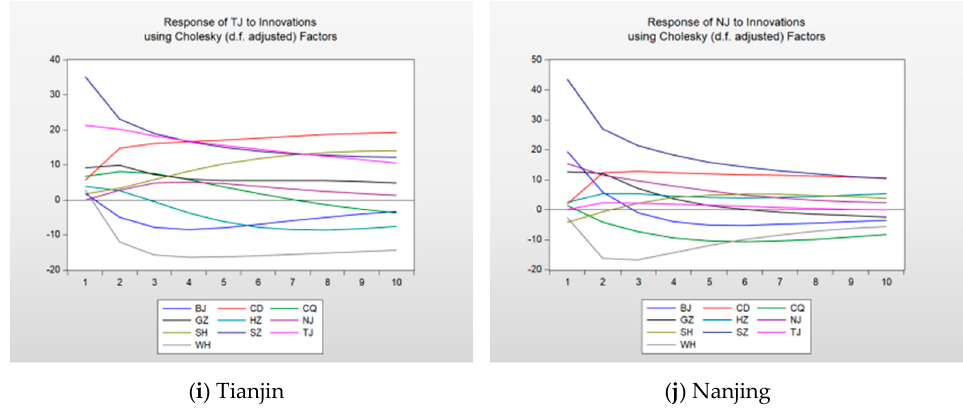
Figure 4. Pulse response chart of information spillover effect in real estate market.